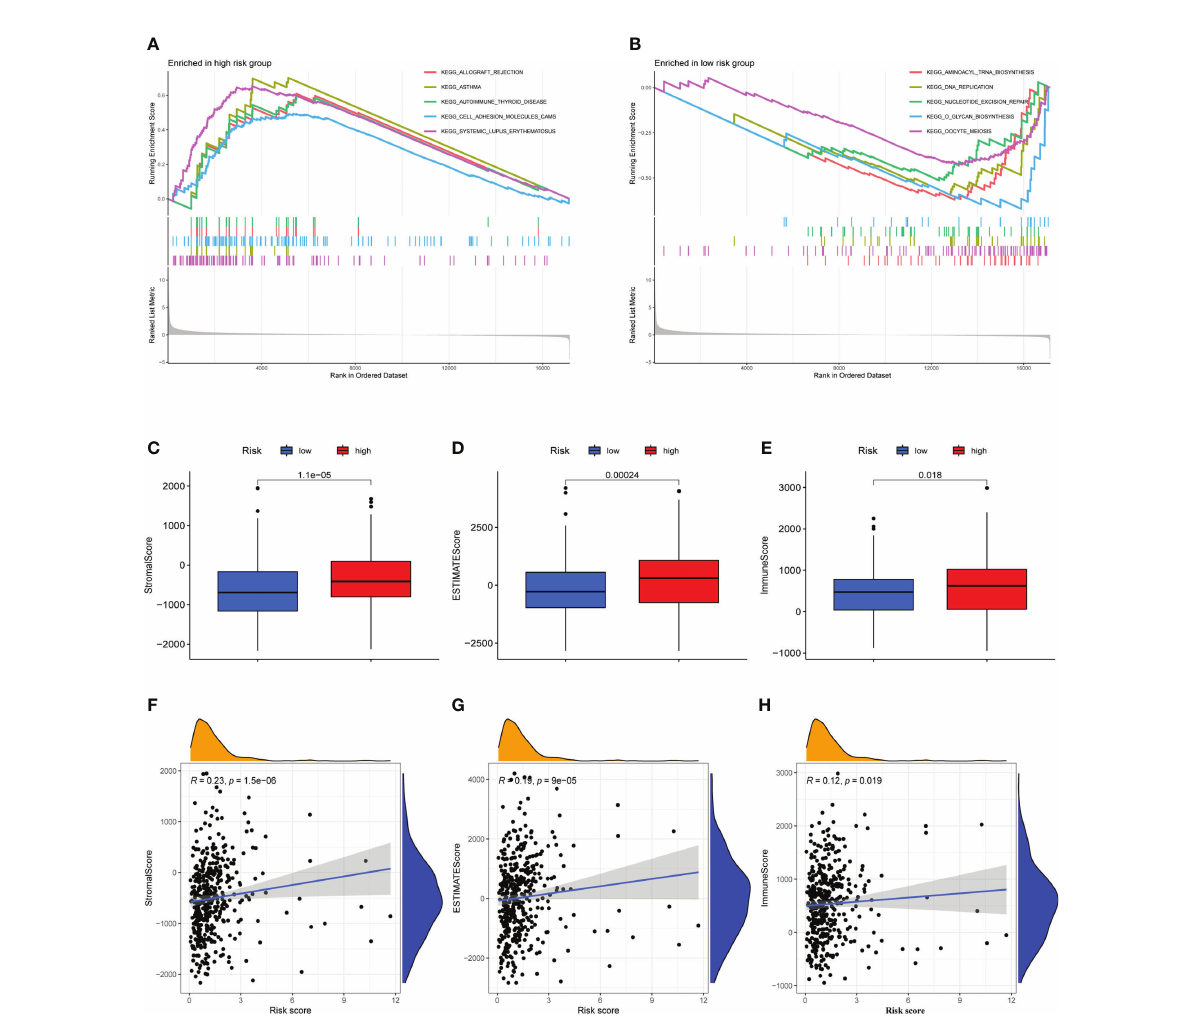
FIGURE 5 Immune microenvironment analysis and gene set enrichment analysis (GSEA). (A) Allograft rejection, asthma, autoimmune thyroid disease, cell adhesion molecules CAMs, and systemic lupus erythematosus are among the enriched KEGG pathways in the high-risk group. (B) Aminoacyl tRNA biosynthesis, dna replication, nucleotide excision repair, O-glycan biosynthesis, and oocyte meiosis are among the enriched KEGG pathways in the low-risk group. (C – E) The high-risk and low-risk groups had considerably different Stromal, ESTIMATE, and Immune scores, with the high-risk group having higher scores. (F – H) A Pearson correlation analysis revealed a strong positive relation between Stromal score, ESTIMATE score, Immune score and risk